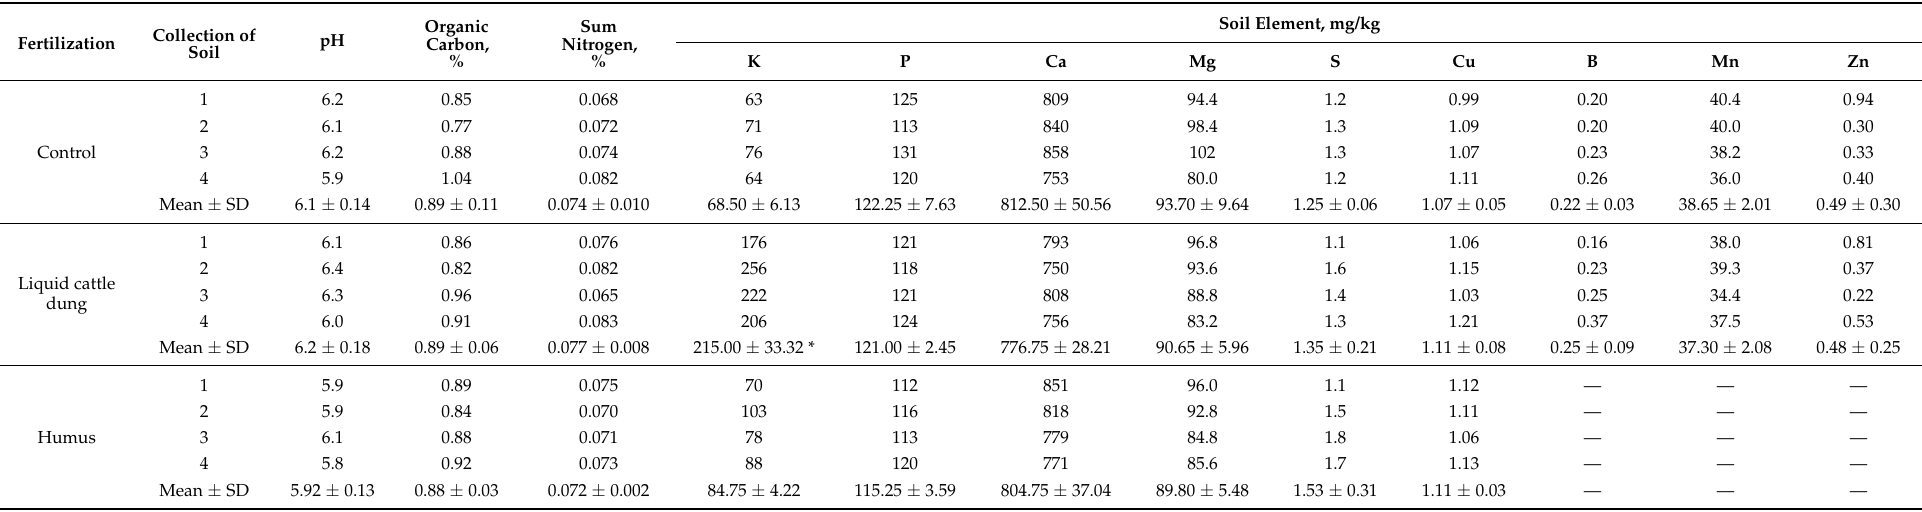
*—statistically significant differences ( p <